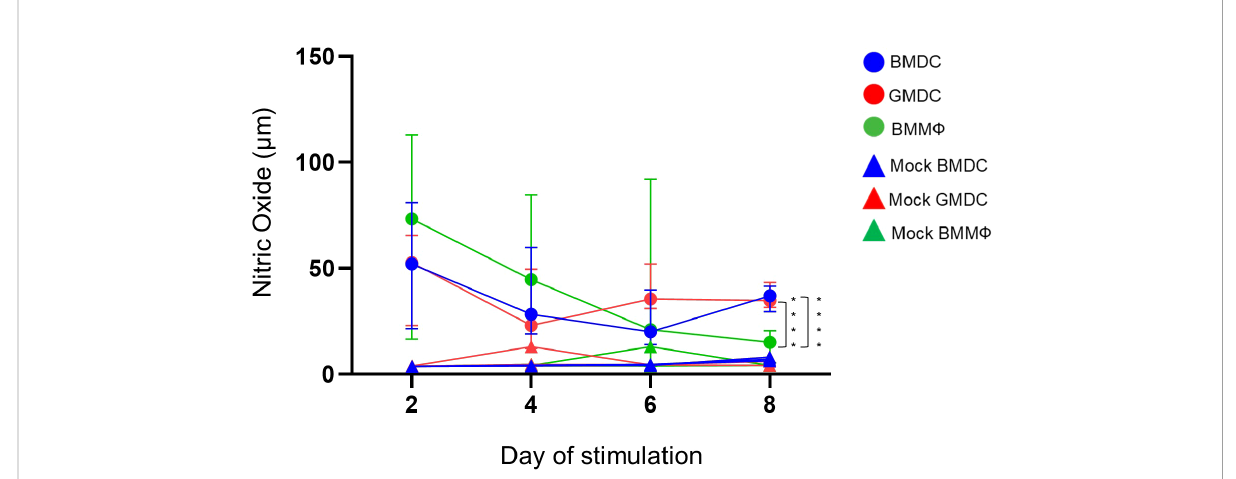
FIGURE 6 BMDC and GMDC produce high NO levels post-LPS treatment. BM cultures were stimulated on days 2, 4, 6 and 8 with LPS from E . coli (circles) or untreated (Mock, rectangles). NO levels in cell supernatant were analyzed 48 h post-treatment using Griess reaction. Data represents the median (± range). From each bird (n=6), BMDC, GMDC and BMM F were generated. Data represents two independent experiments (n=3 per experiment, open & closed circles). Signi fi cant differences between the cultures on the day of stimulation are indicated by * p<0.05 and